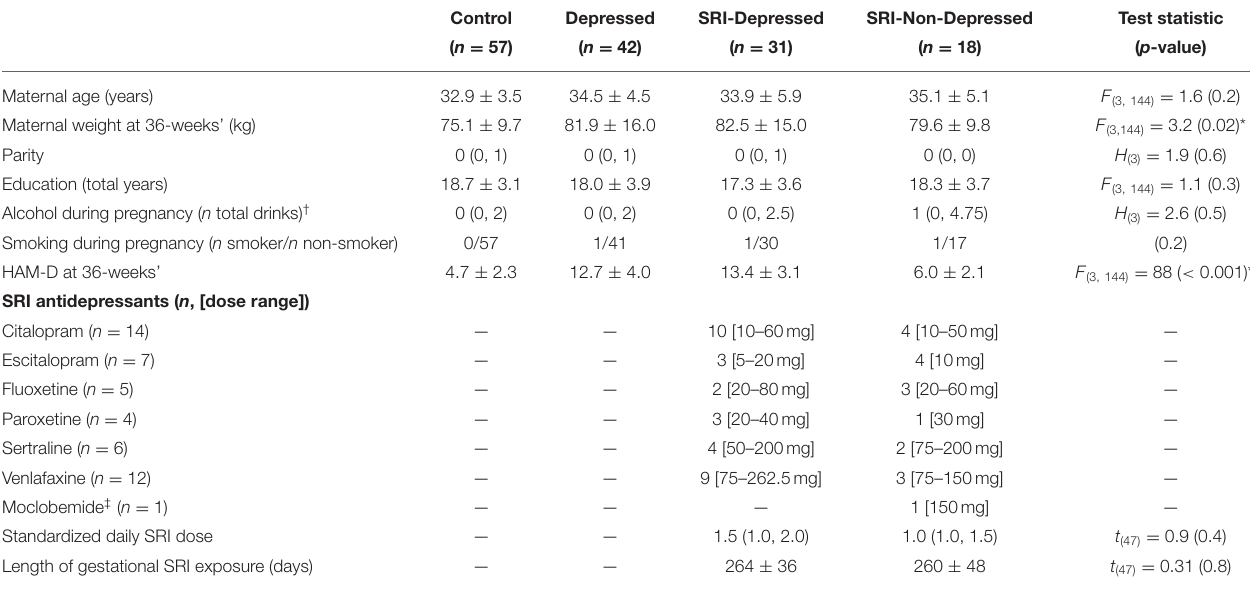
TABLE 1 | Maternal characteristics ( n = 148).